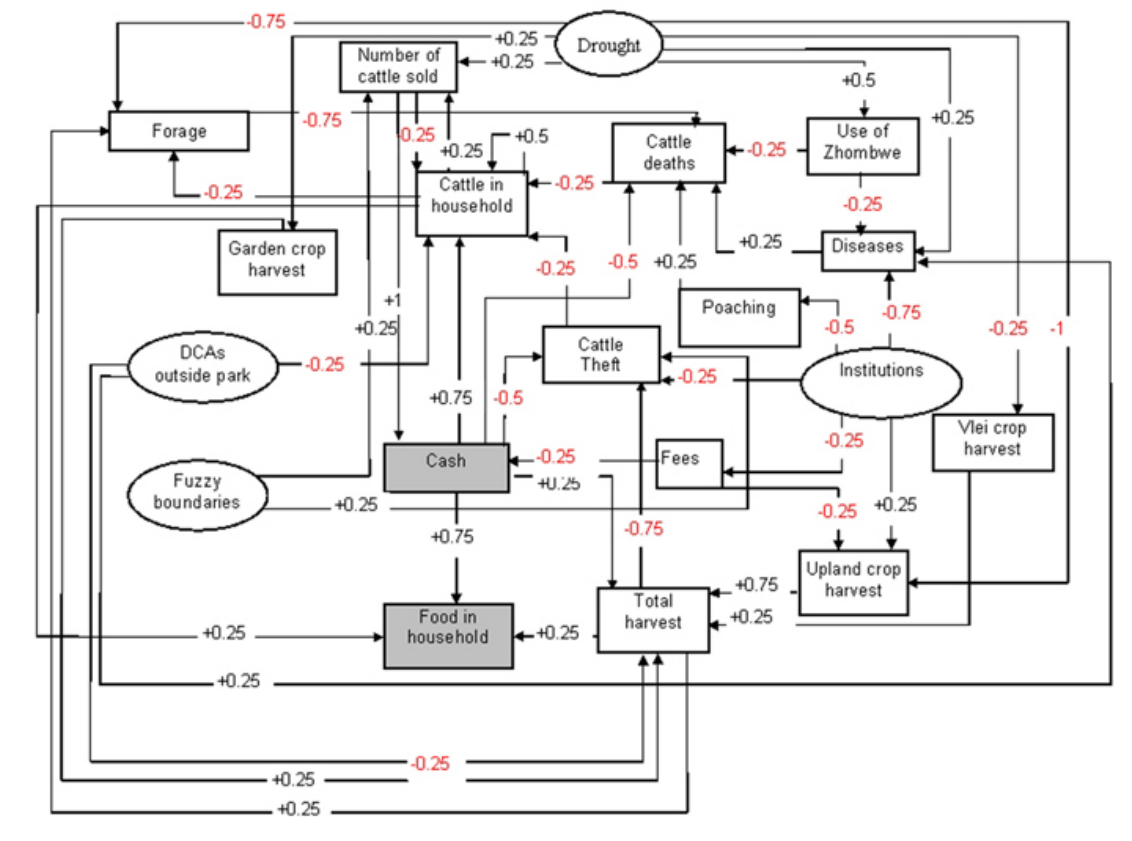
Fig. 4. Fuzzy cognitive map of the cattle-based livelihood type. Grey boxes are key indicators of the functioning of the livelihood; white boxes are variables; white circles are system drivers. Numbers given are influences between factors, where red font indicates negative relationships, and black font indicates positive relationships.